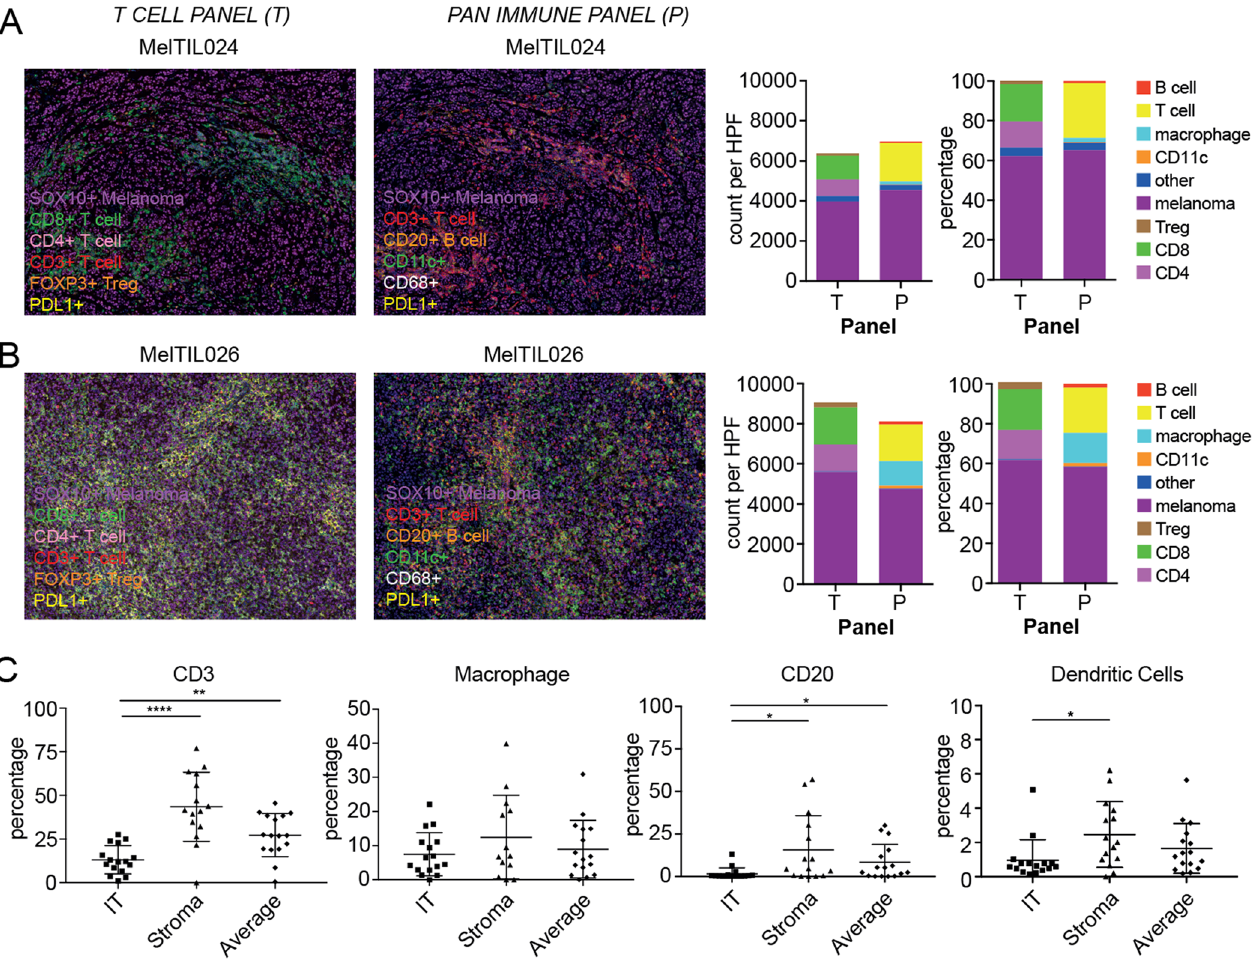
Figure 2. Multiplex IHC reveals the broader immune context of metastatic melanoma. FFPE sections of metastatic melanoma from MelTIL024, s.c. arm metastasis ( A ) and MelTIL026, pelvic lymph node metastasis ( B ) were stained by OPAL for the “T-cell Panel” including SOX10 (melanoma marker), PDL1, CD3, CD8, CD4 and FOXP3 and in the “Pan-Immune Panel” SOX10, PDL1, CD3, CD20, CD68 and CD11c. Stained sections were imaged on the Vectra Automated Imaging System and composite HPF images displayed. The T cell Panel showed the distribution of tumour cells (purple), PDL1 (membranous yellow) on either melanoma or infiltrating APCs, CD8 + T cells (green), CD4 + T cells (pink) and T regulatory T cells (orange nucleus). The pan-immune panel showed distribution of tumour cells (purple), PDL1 (membranous yellow) on either melanoma or infiltrating APCs, CD3 + T cells (red), CD20 + B cells (orange), CD68 + macrophages (white cytoplasmic), and CD11c + likely dendritic cells (green membranous). High-powered fields were selected based on highest TIL density, and cell populations measured using inform v2.2 software. Immune context quantitation from the T cell panel and pan immune panel was recorded and plotted in Graph Pad PRISM as counts per HPF and % of total cells for each resected metastasis. Collated data for all Mel-TIL samples in the study cohort is depicted in ( C ) including the % of T cells (CD3), B cells (CD20), macrophages (CD68) and CD11c + (likely dendritic cells) in three tumour regions (IT, TM and S) as well as the average of these regions. Statistical analysis (Mann Whitney) was performed across the cohort, significantly different data is represented by * (p < 0.05), ** (p < 0.01) and **** (p <